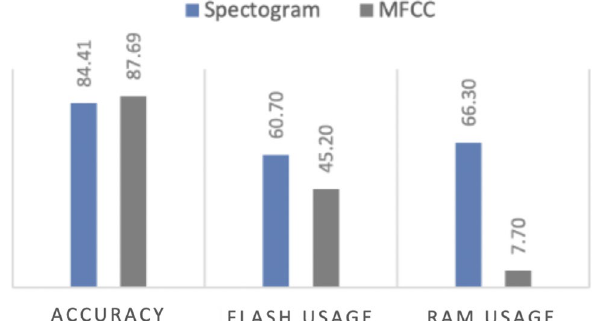
Fig. 7 Comparison of the sys- tem performance using MFCC vs.